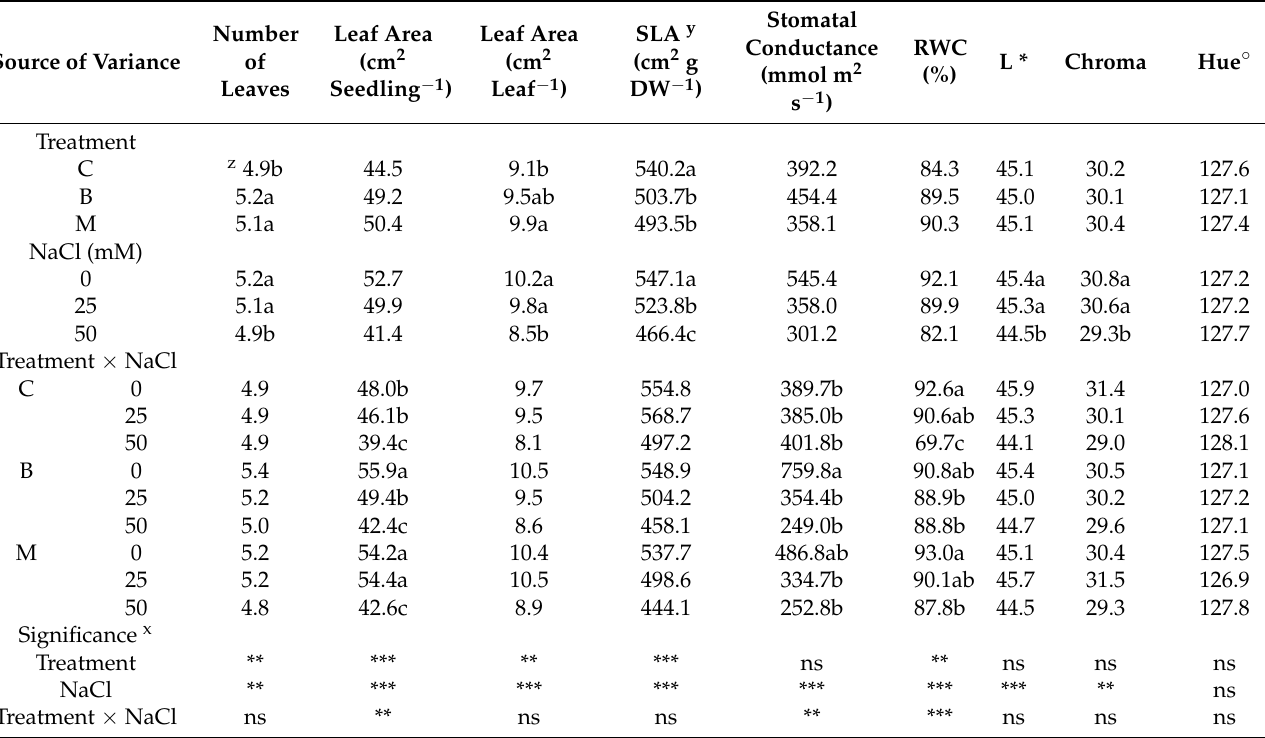
Table 4. Effects of microbial biostimulant treatment (C, not treated; B, Bactorr S13 ; M, Flortis Micorrize) and salt stress (0, 25, and 50 mM NaCl in the irrigation water) on the leaf characteristics of tomato